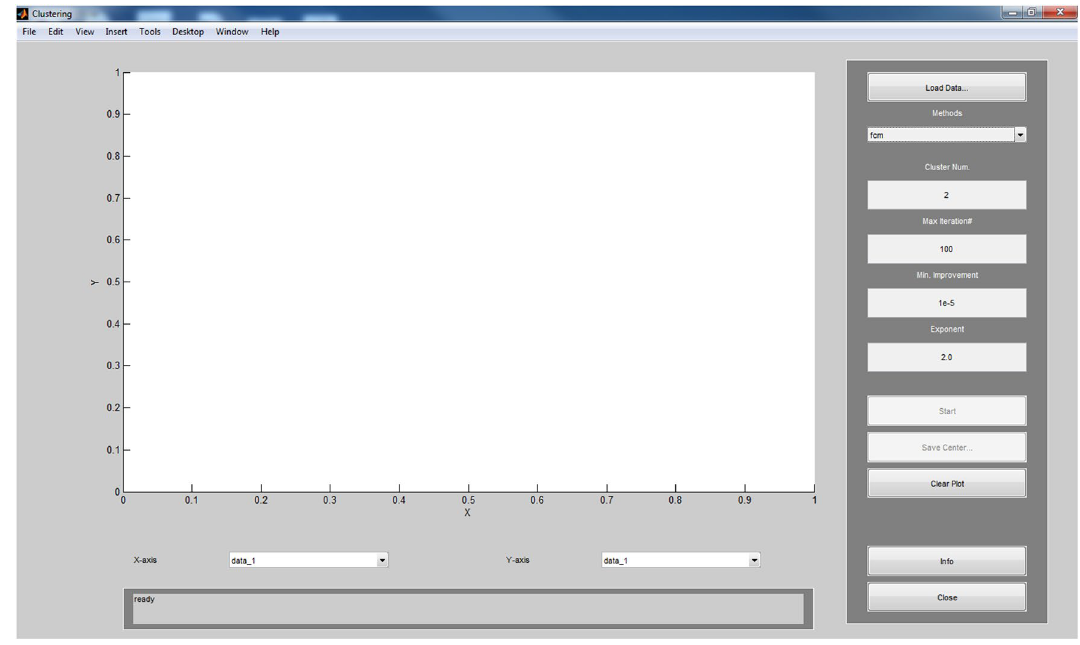
Fig. 1 Basic layout of clustering toolbox in